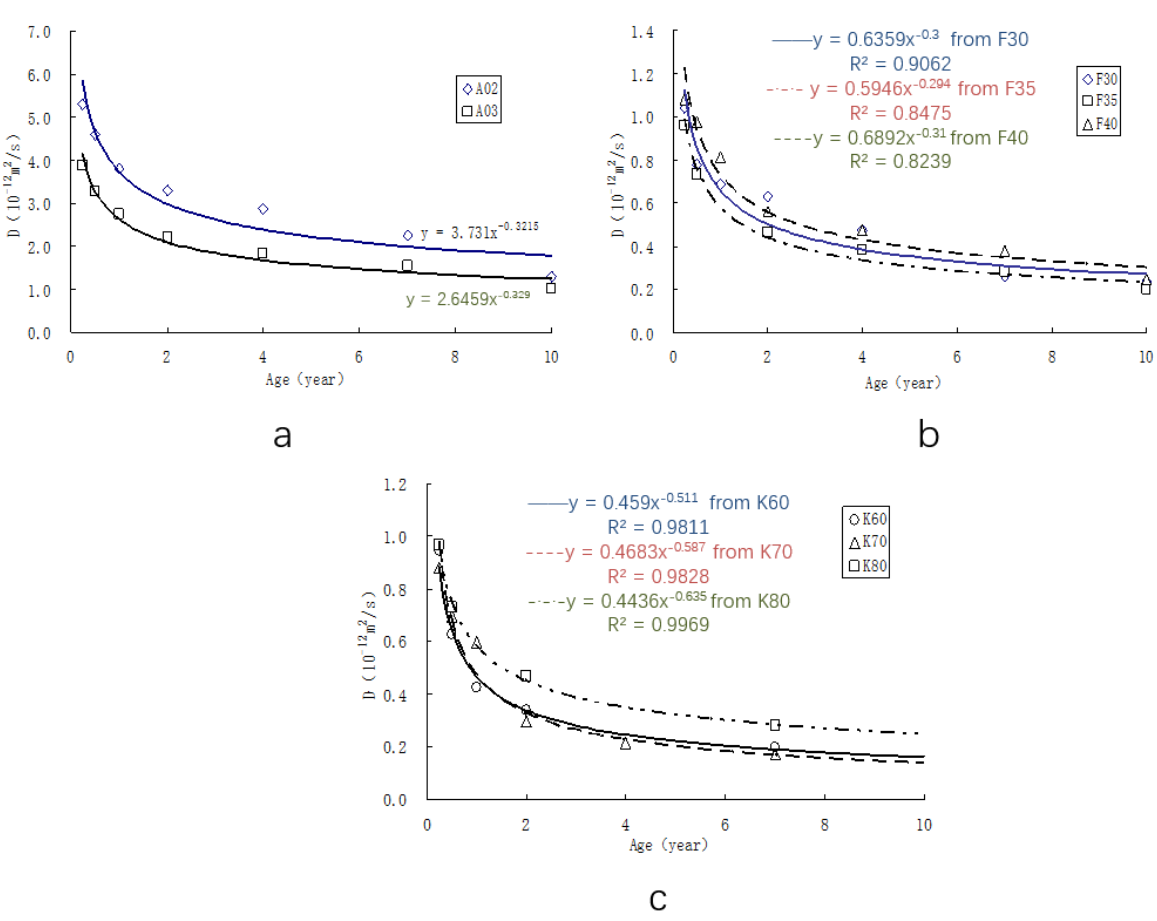
Figure 3. Chloride diffusion coefficient–time curves of concrete with different mineral admixtures based on exposure. ( a ) Portland cement concrete, ( b ) FA concrete, ( c ) GGBS concrete.